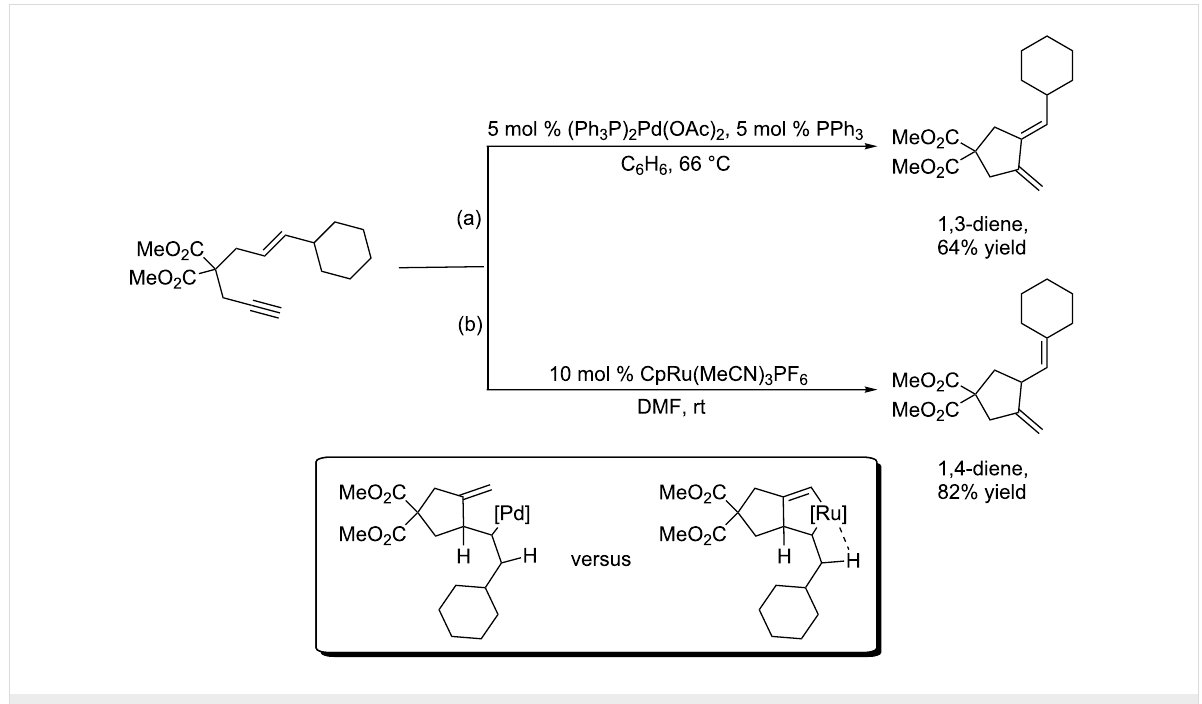
Scheme 1: Divergent behavior of the palladium and ruthenium-catalyzed Alder–ene reaction .